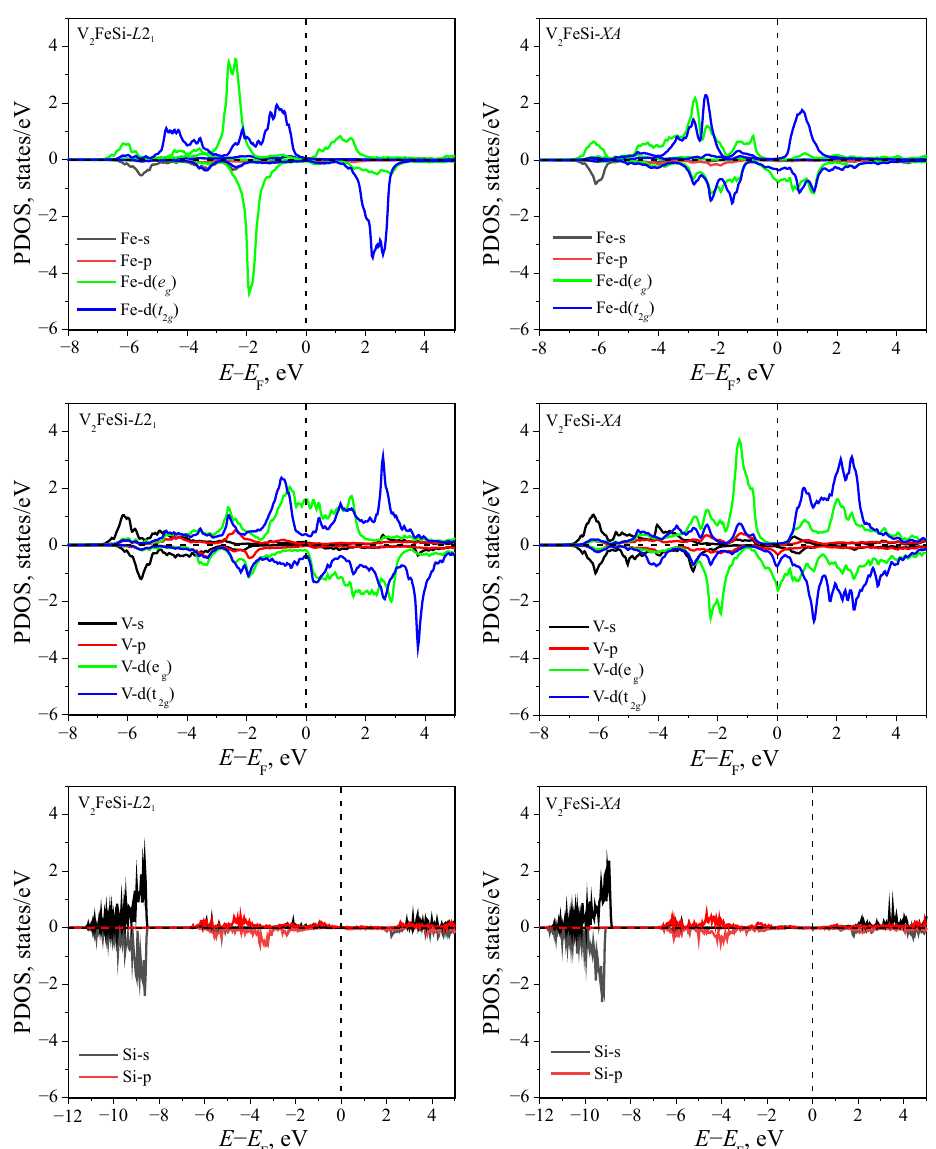
Figure 3. The partial density of states for V 2 FeSi of both L 2 1 and XA structures. Zero on the energy axis corresponds to the Fermi